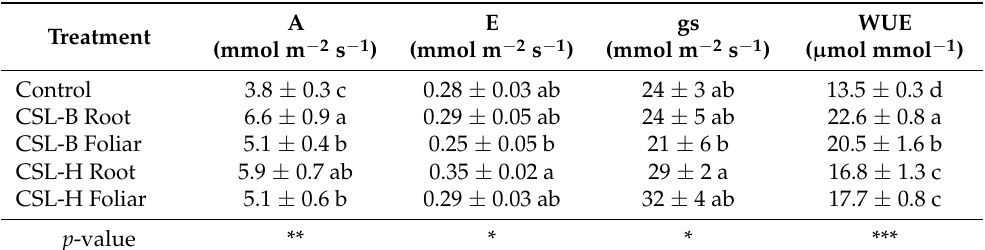
Table 2. Gas exchange parameters of the plants according to the treatment. A: net assimilation of CO 2 , E: leaf transpiration, gs: stomatal conductance, WUE: water use efficiency. Treatment